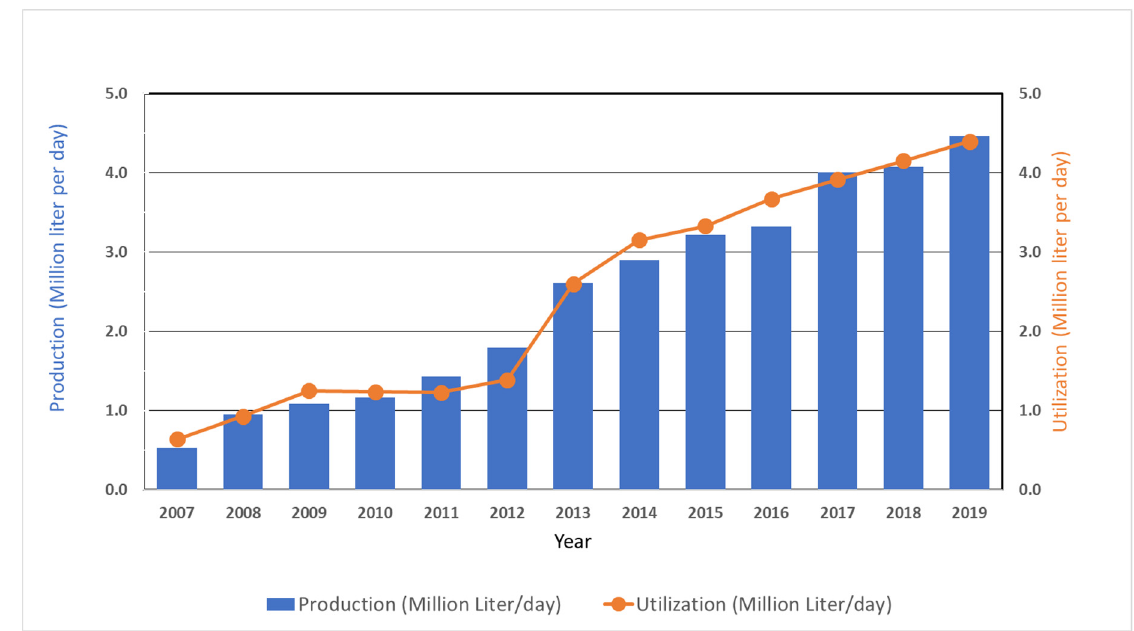
Figure 3. Ethanol production and consumption in Thailand